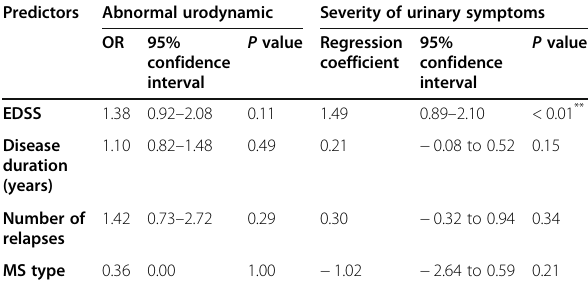
Table 6 Predictors of abnormal urodynamic and severity